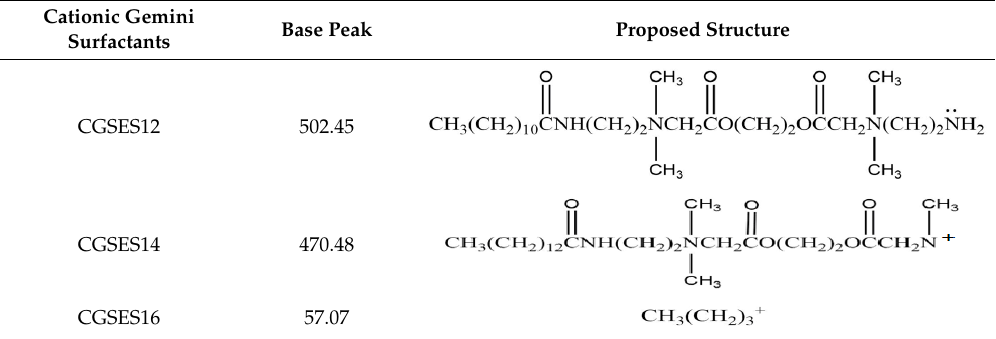
Table 3. GC-MS data of CGSES12-16.